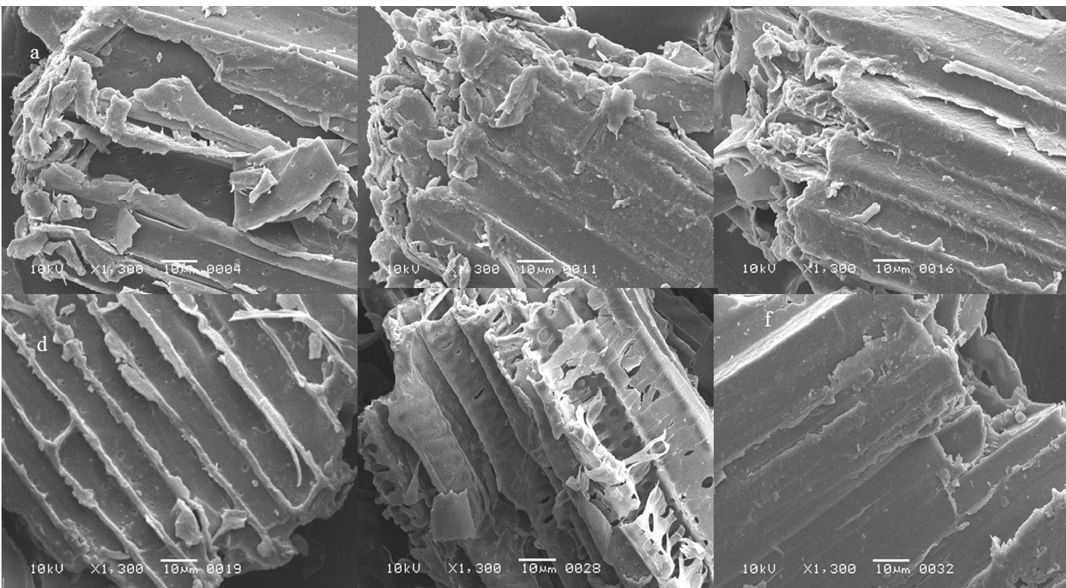
Figure 3. Scanning electron microscopy of ( a ) acid pre-treated SB, ( b ) acid pre-treated SB obtained after experiment 1, ( c ) after experiment 2, ( d ) after experiment 3, ( e ) after experiment 4, ( f ) after experiment 5.